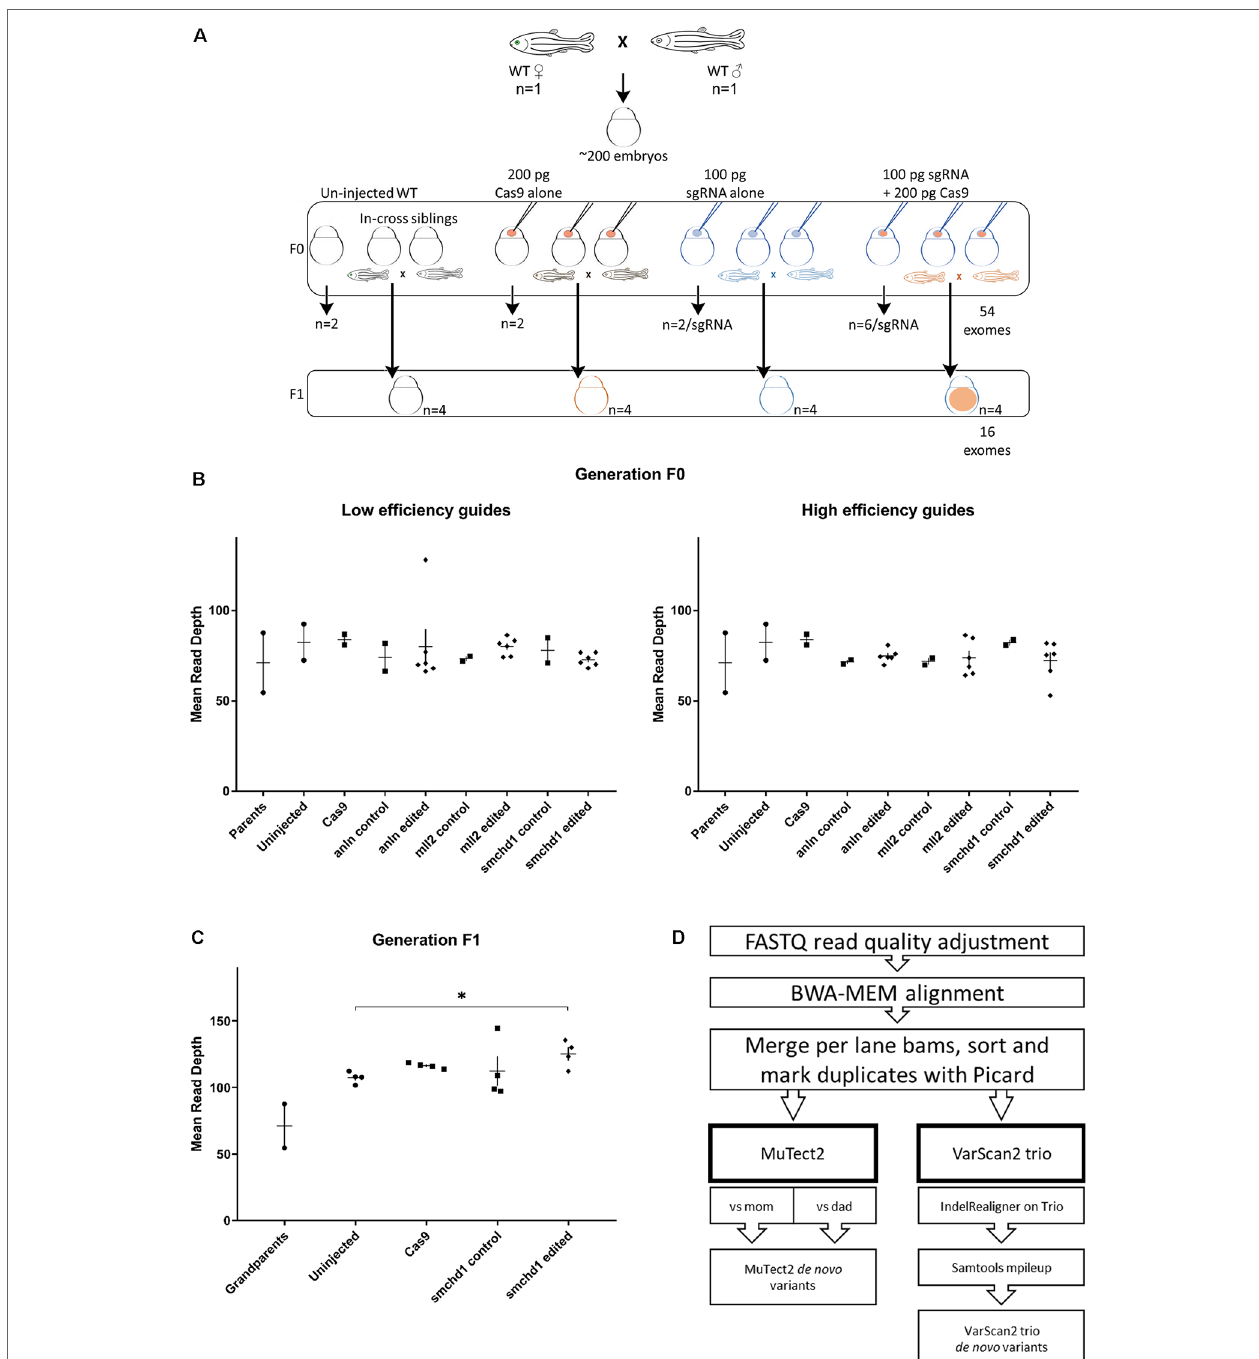
FIGURE 1 | Whole exome sequencing in two generations of CRISPR-Cas9 edited zebrafish. (A) The experimental design generates a single clutch of ~200 embryos from a founder pair of parents from the ZDR laboratory strain of wild-type zebrafish. The embryos were randomly assigned to four experimental arms: uninjected controls, Cas9 injected controls, sgRNA injected controls, and Cas9 + sgRNA gene edited samples. A total of 52 embryos were sampled for DNA extraction and sequencing at 4 dpf in the F0 generation (2 uninjected, 2 Cas9 injected, 2 sgRNA injected across 6 different sgRNAs targeting 3 genes for a total of 12 embryos, and 6 CRISPR-Cas9 embryos per sgRNA guide for a total of 36 edited individuals). Additional embryos for each condition were injected concurrently, but raised to adulthood. The F0 in-cross from pairs edited with the smchd1 high efficiency guide generated F1 progeny for further sequencing: We sampled offspring from 4 uninjected, 4 Cas9 injected, 4 sgRNA injected, and 4 CRISPR-Cas9 injected embryos for a total of 16 F1 exomes. (B) The first round of exome sequencing (F0 and parents) generated a consistent read depth averaging 76x coverage. (C) The second round of exome sequencing (F1) generated a consistently higher read depth averaging 115x coverage. The smchd1 edited individuals are also sequenced to a higher depth than the uninjected controls (p < 0.05). (D) After sequencing quality control and alignment, variant calling was performed with both somatic and germline callers to identify candidate de novo